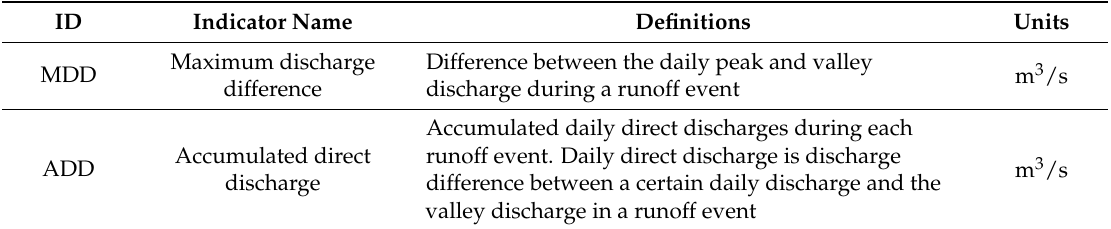
Table 2. Precipitation and temperature indices based on daily precipitation and temperature during their associated runoff events.